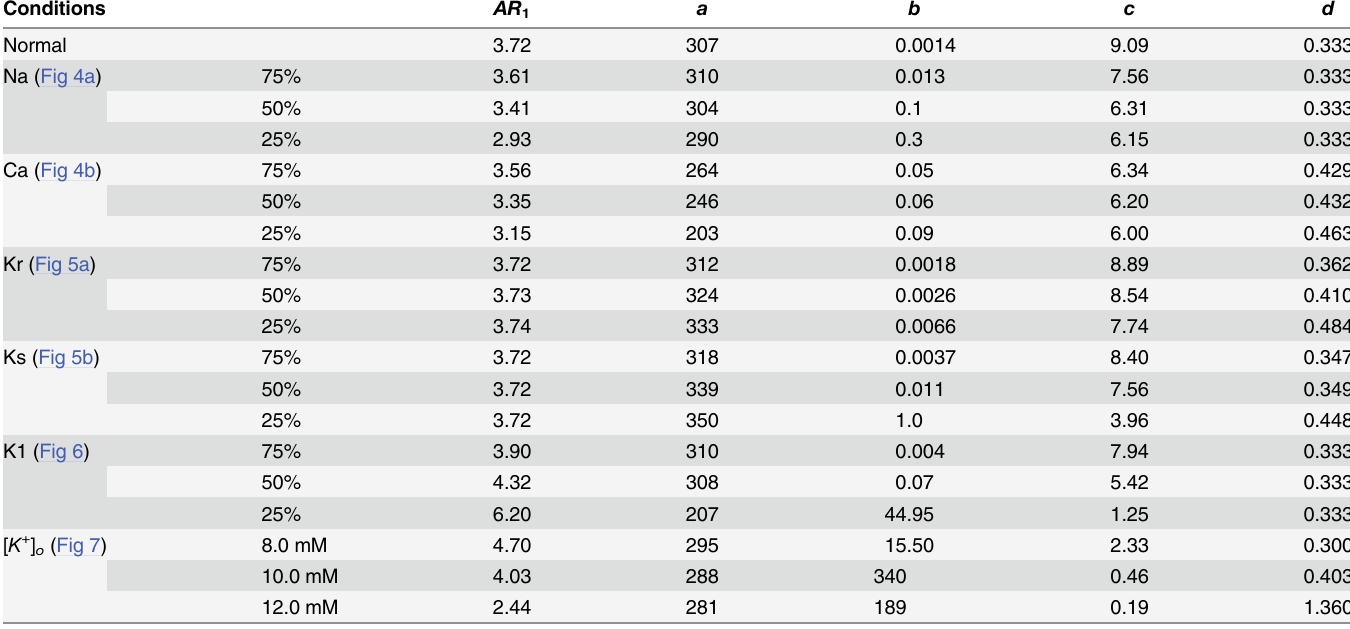
Table 1. Critical anisotropy ratio and fitting parameters.